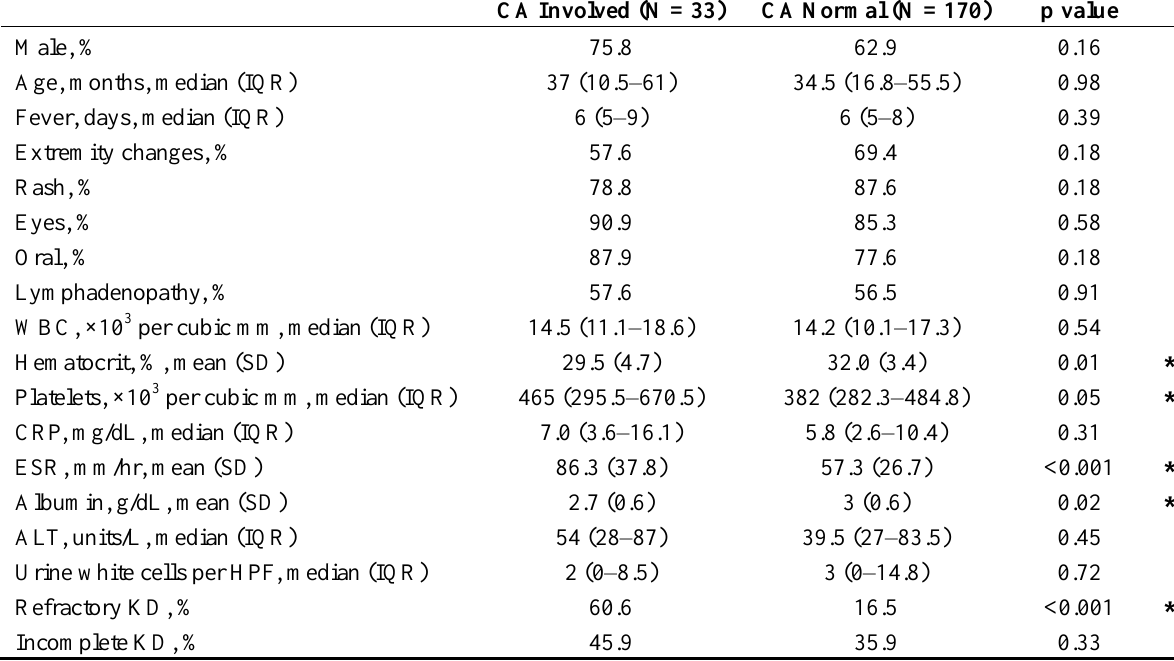
Table 1. Comparison of clinical and laboratory parameters between patients with and without coronary artery involvement. Abbreviations: CA, coronary artery; IQR, interquartile range; CRP, C-reactive protein; ESR, erythrocyte sedimentation rate; WBC, white blood cell; SD, standard deviation; ALT, alanine aminotransferase; HPF, high power field; KD, Kawasaki disease ( * p value ≤ 0.05 was considered statistically significant).